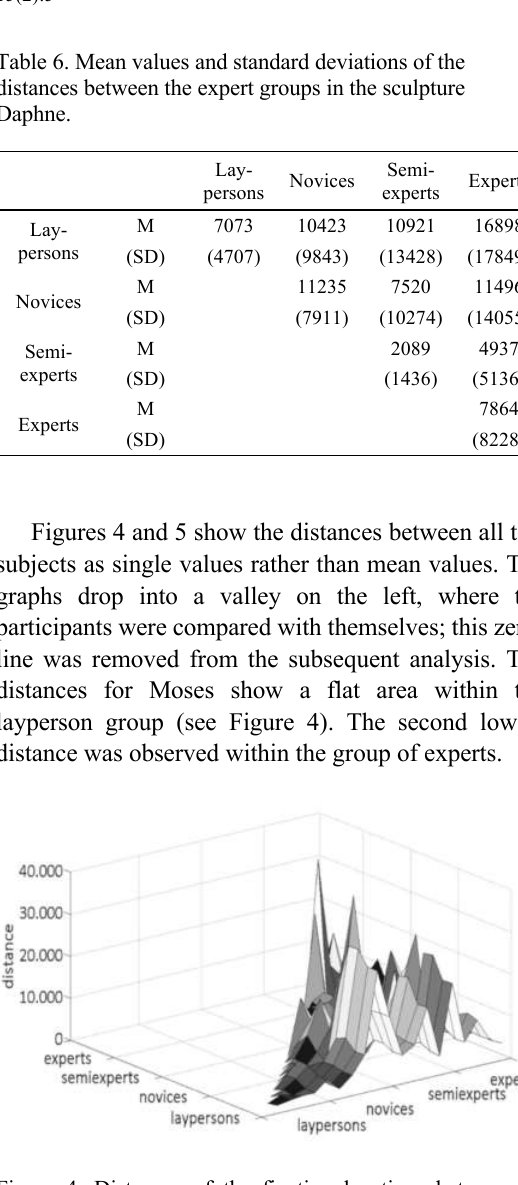
Figure 4. Distances of the fixation locations between all participants on the sculpture Moses.